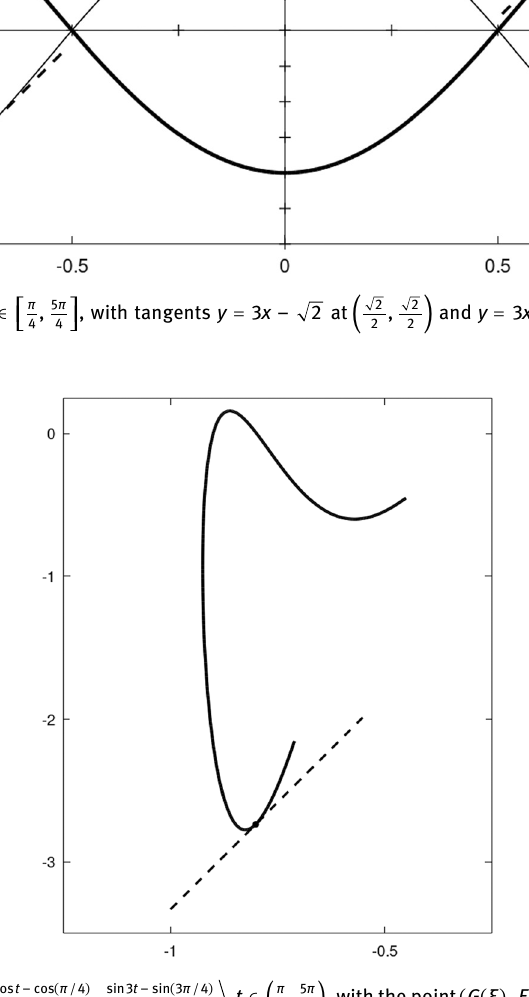
Figure 2: Plot of ( ) ( ) its tangent = y x 3 − 0.33275 ( correct to fi ve decimals )